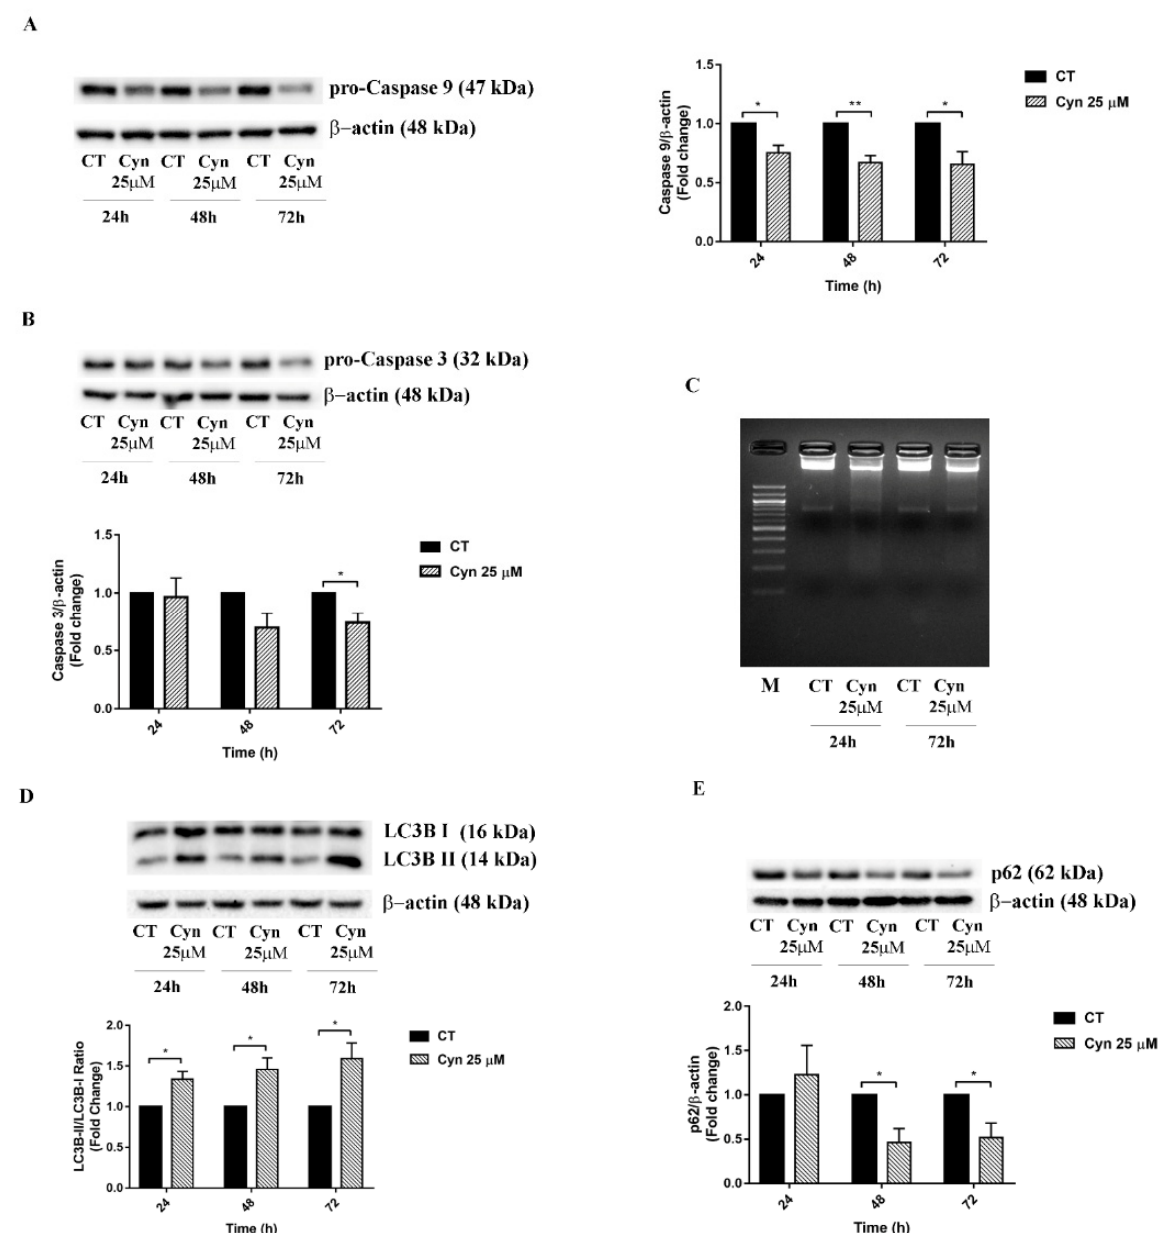
Figure 4. Activation of U-87 MG cell death pathways under acute treatment with Cyn. ( A,B ) Western blot analysis of pro-Caspase 9 and pro-Caspase 3 reduction in U-87 MG cells treated with Cyn 25 µM for 24, 48 and 72 h of exposure. Densitometric analysis of the protein levels represent the means ± SEM of 3 individual determinations. Data were normalized to housekeeping gene Actin and are expressed as a fold change over control treated cells. Statistical analysis was performed with the Student’s t -test, p -value < 0.05. According to GraphPad Prim 7 software, a ** p -value from 0.05 to 0.01 was considered significant and ** p -value from 0.001 to 0.01 very significant. ( C ) Agarose gel electrophoresis of DNA extracted from U-87 MG cells treated with Cyn 25 µM for 24 and 72 h. DMSO 0.1% was used as the vehicle control. ( D,E ) Western blot analysis of autophagic markers LC3B and p62. Densitometric analysis of protein levels represents the means ± SEM of 3 individual determinations. For LC3B, data were reported as a LC3B II/I ratio, while, for p62, the values were normalized to housekeeping gene Actin. The results are expressed as a fold change over control-treated cells. Statistical analysis was performed with the Student’s t -test, p -value < 0.05. According to GraphPad Prim 7 software, a * p -value < 0.05 was considered significant.